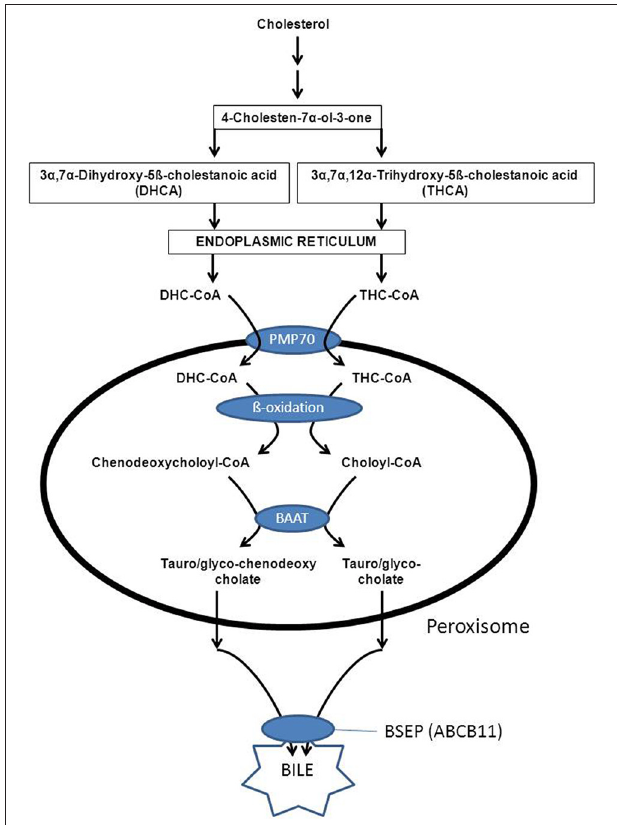
FIGURE 8 | Schematic diagram showing the unique and important role of peroxisomes in the formation of the primary bile acids cholic acid and deoxycholic acid. See text for detailed